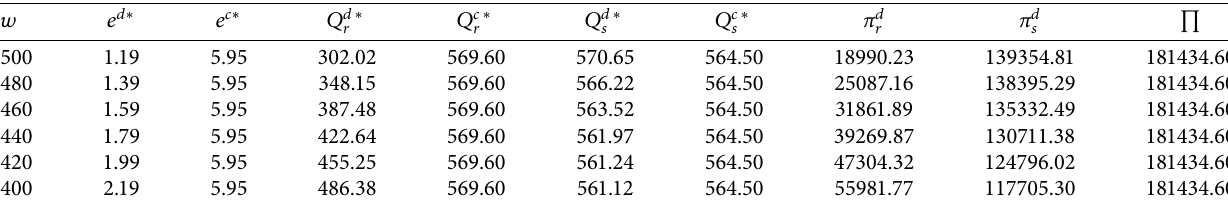
Table 3: Sensitivity analysis of wholesale price w .